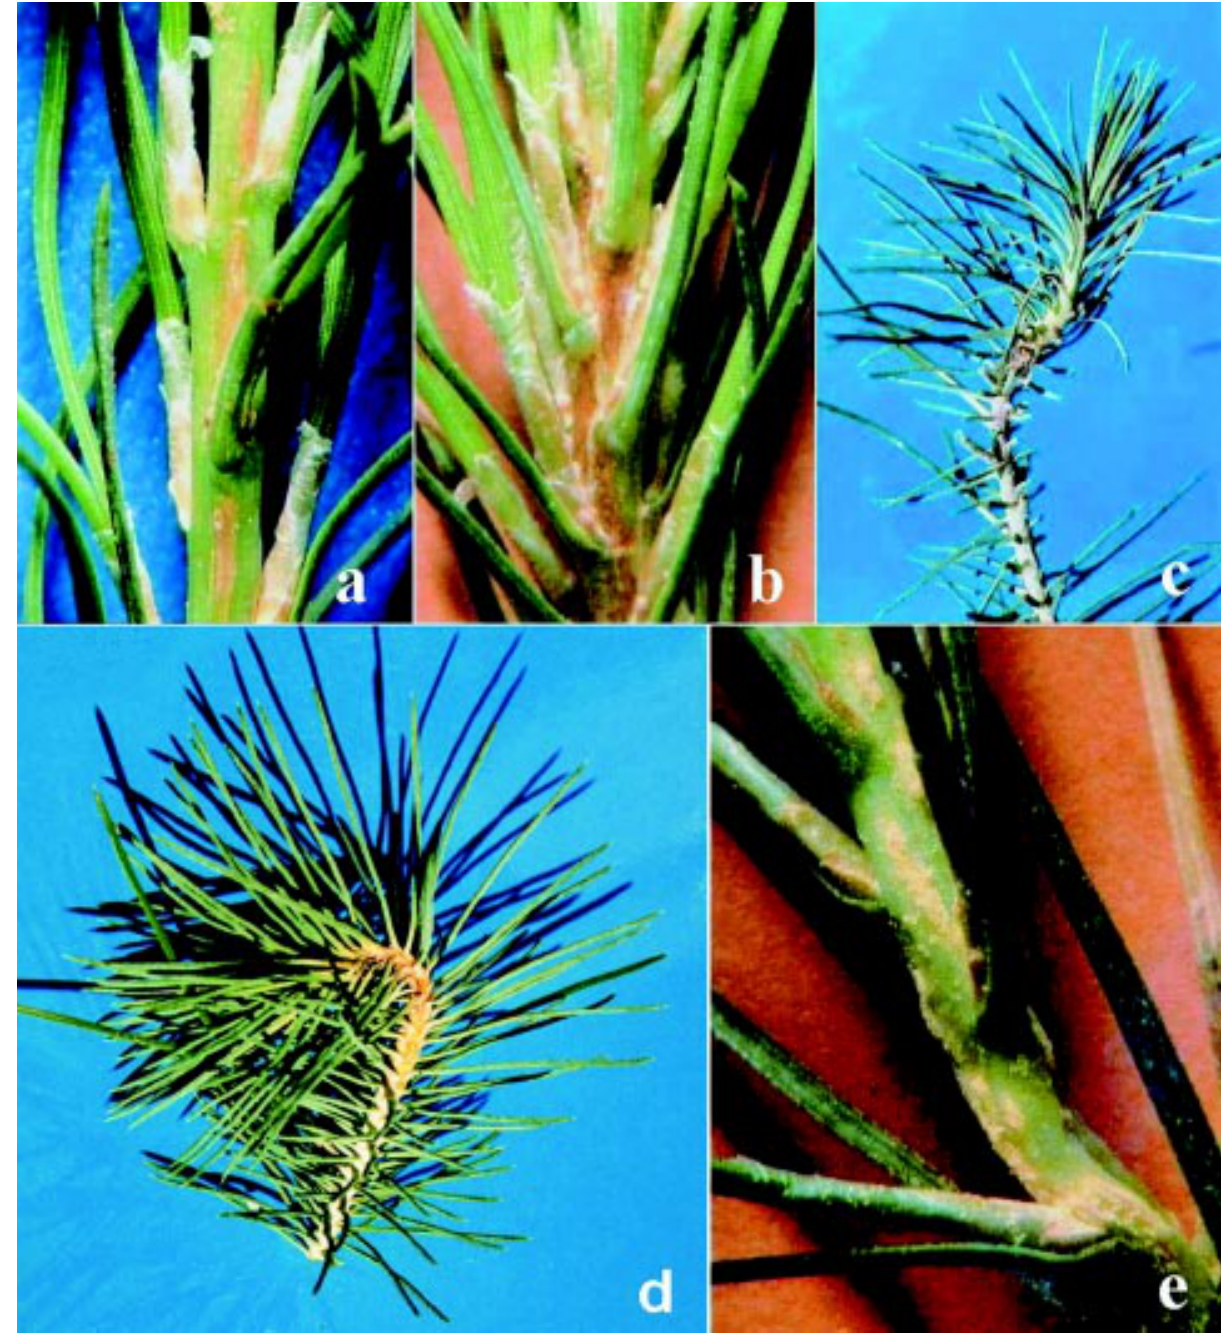
Fig. 1. a, b, c. Cortical necroses on shoots of Pinus inoculated with Melampsora larici-tremulae from a, Baiardo; b, Luson; c, Vallombrosa; a, Pinus nigra subsp. laricio with small light-yellow necroses; b, P. sylvestris with large brownish necroses; c, P. pinea with extended necrosis and twisting. d, e. Shoots of Pinus inoculated with M. pini- torqua from Monticiano; d, P. pinea with aecia and characteristic twisting; e, P. nigra subsp. laricio with